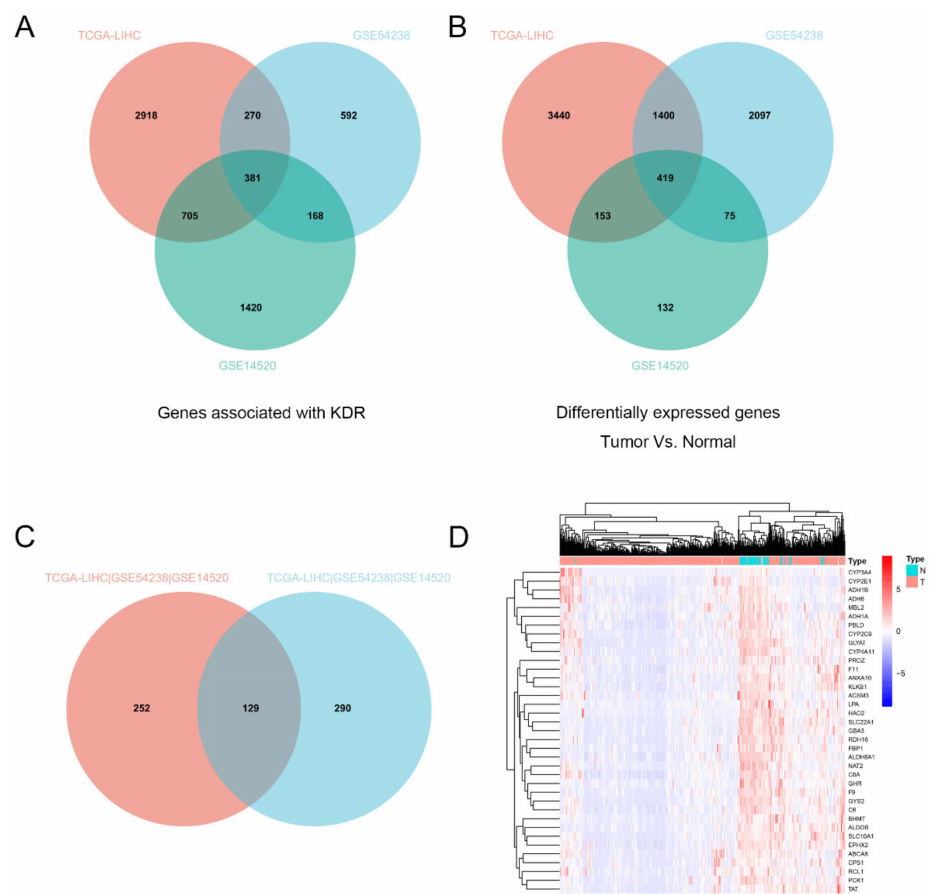
Figure 1. ( A ) Intersection analysis of KDR-associated genes in the TCGA database (LIHC) and GEO database (GSE54238, GSE14520). ( B ) Intersection analysis of differential genes (normal vs. tumor) in TCGA database (LIHC) and GEO database (GSE54238, GSE14520). ( C ) Intersection analysis of KDR -associated genes and the differential genes between normal and tumor. ( D ) 37 screened genes were differentially expressed by logFC >